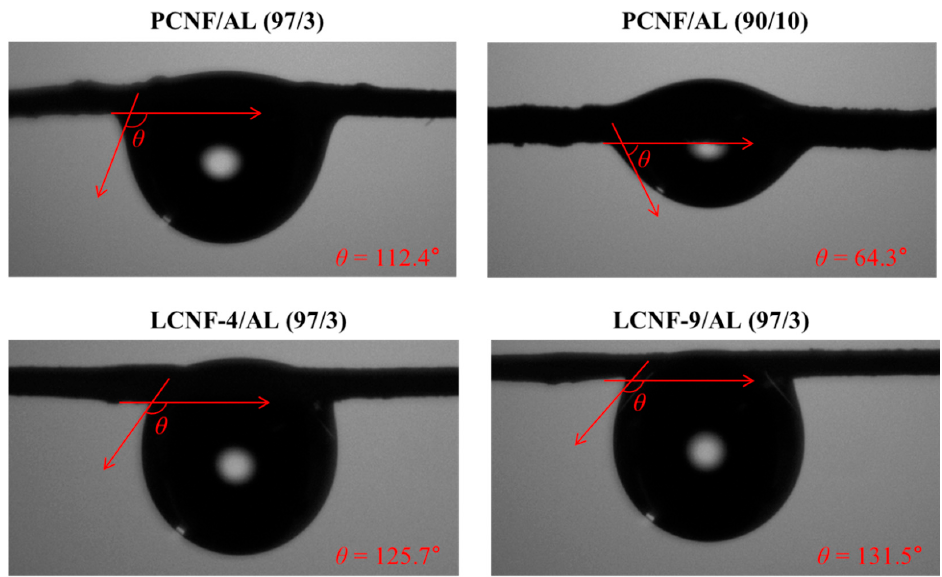
Figure 10. Contact angles of wet-spun composite filaments from PCNF/AL, LCNF-4/AL, and LCNF-9/AL.